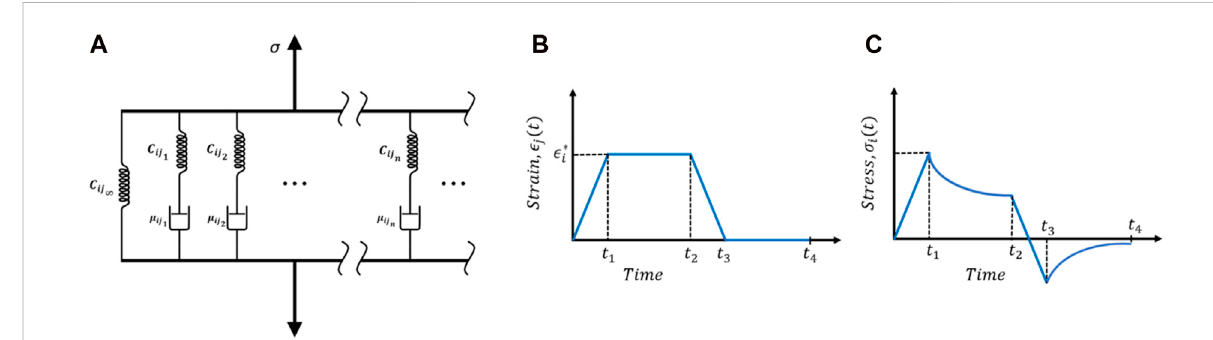
FIGURE 5 (A) General Maxwell viscoelastic model. Typical relaxation test: (B) time history of volume-averaged strain and (C) stress